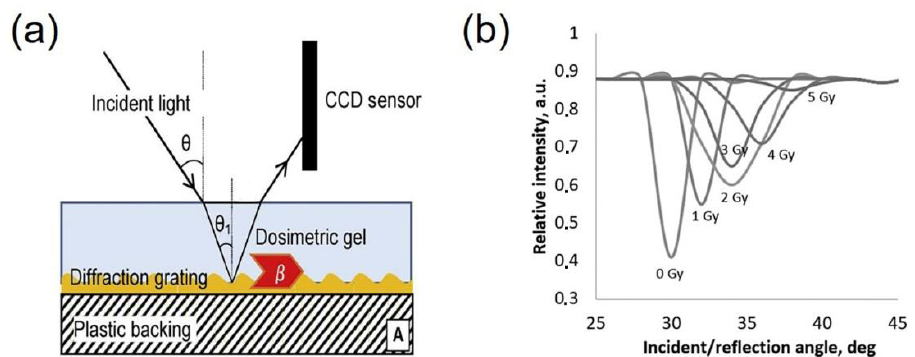
limit of detection (LOD) of such a dosimeter was as low, at 0.2 Gy, and its sensitivity was 0.168 Gy − 1 .